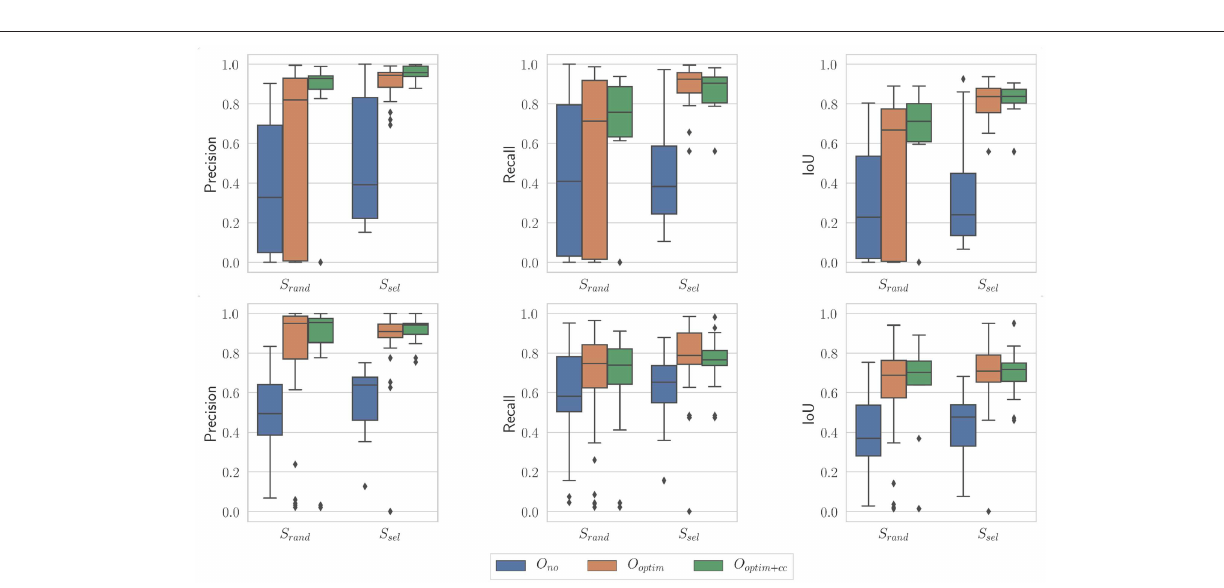
FIGURE 13 | Boxplots showing the evaluation metrics for N = 100 ; i = 10. (Top) In vivo dataset; (Bottom) Benchtop dataset. The random seed used is different from the one in Figure 11